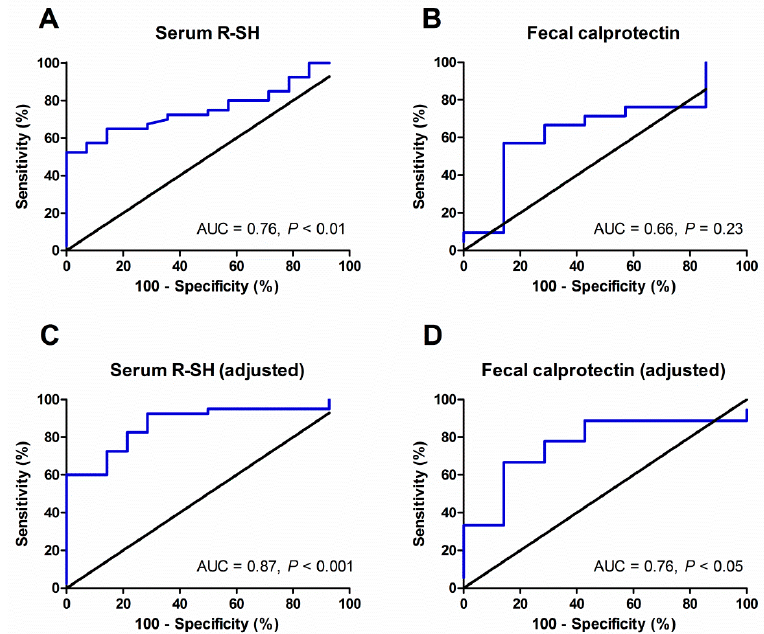
Figure 3. Albumin-adjusted serum free thiol (R-SH) levels ( A ) discriminate better between mild (1) and moderate-to-severe (2,3) endoscopic disease activity as compared to fecal calprotectin levels ( B ), even after adjustment for potentially confounding factors ( C–D ).